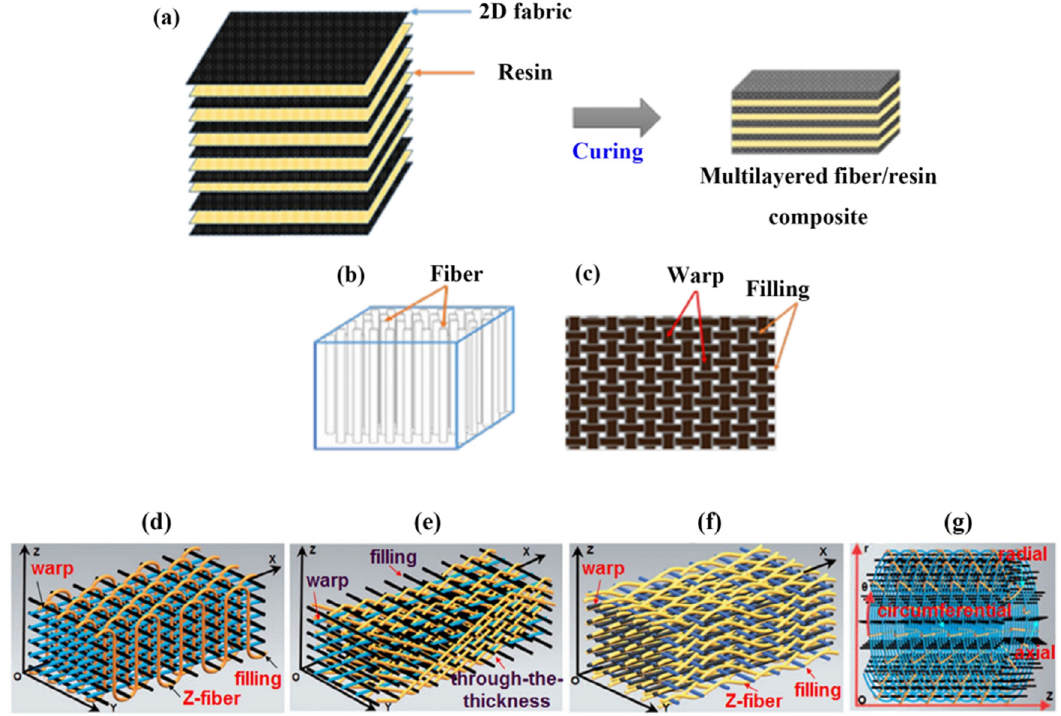
Figure 5: FRP structure forms from 1D to 3D. ( a ) Typical preparation method of FRP laminates, ( b ) unidirectional structure, and ( c ) 2D woven fabrics. The reinforcement methods to improve the out - of - plane properties of FRPs: ( d ) 3D orthogonal preform, ( e ) 3D through - the - thickness preform, ( f ) 3D angle interlock preform, and ( g ) 3D orthogonal circular preform [ 36 ] .